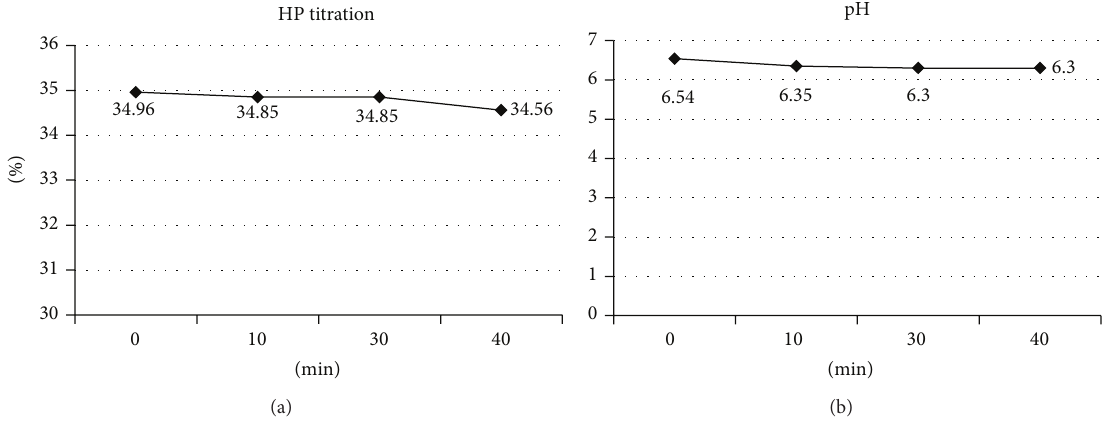
Figure 3: HP titration (a) and pH evaluation